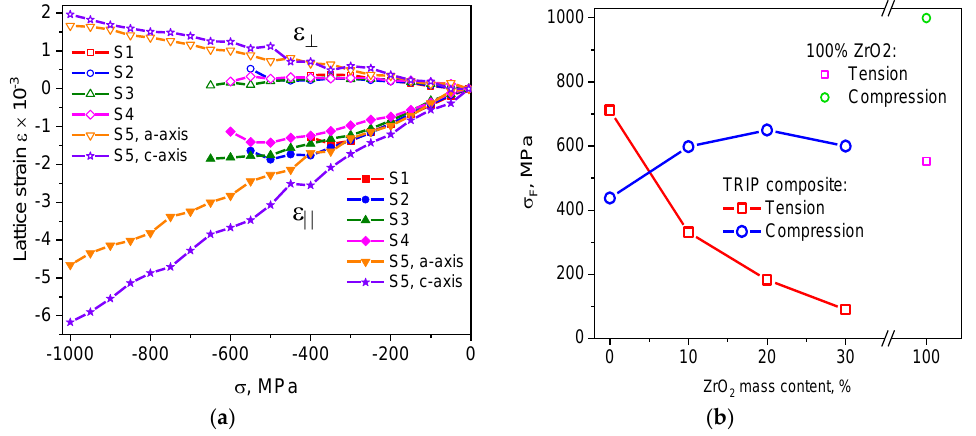
Figure 21. ( a ) Longitudinal and transverse lattice strain determined from the relative change in the lattice parameter for the austenitic matrix of the TRIP-composite for samples S1-S4 and for the ceramic sample S5 (100% ZrO 2 ). ( b ) The ultimate stress of the TRIP composite vs. ZrO 2 content, adapted from [45], with permission from © 2018 Springer.